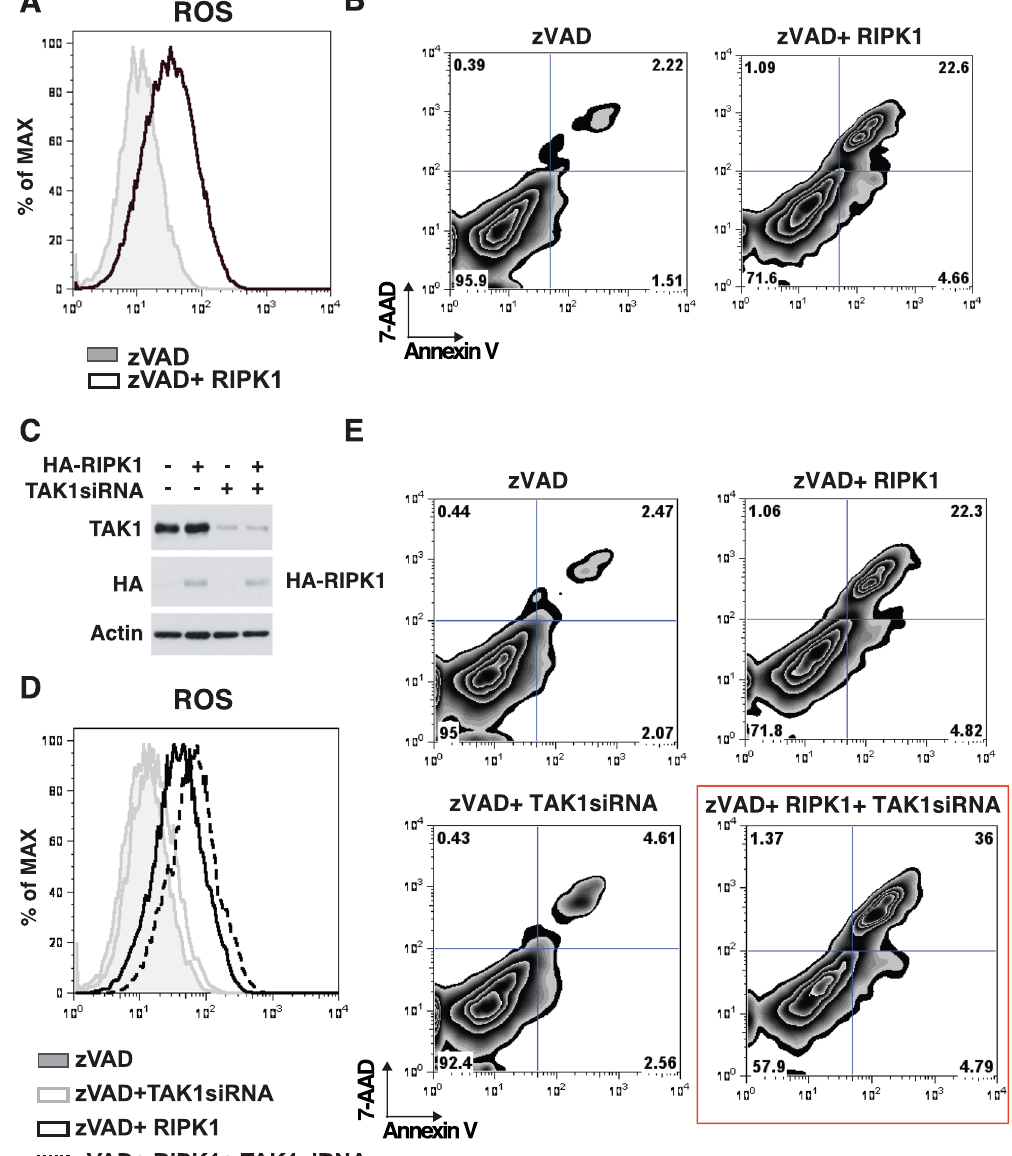
Figure 5. RIPK1 induces ROS accumulation and cell death in the absence of RIPK3 and caspase activities. ( A and B ) HeLa cells were transfected with an expression vector for GFP-tagged RIPK1 or GFP together with 20 µ M zVAD, incubated for 24 h, and stained with CellROX dye or Annexin V-APC and 7-AAD, then analyzed on a flow cytometer. ( C ) Proteins expression of TAK1 and RIPK1 were analyzed by immunoblotting. β -actin is shown as a loading control. ( D and E ) HeLa cells were transfected with siRNA targeted against TAK1 gene, incubated for 24 h and then transfected with an expression vector for GFP-tagged RIPK1 or GFP together with 20 µ M zVAD, incubated for another 24 h, and stained with CellROX dye or Annexin V-APC and 7-AAD, then analyzed on a flow